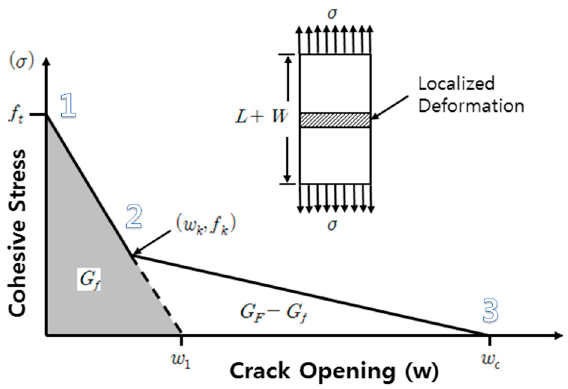
Figure 8. Bilinear approximation of the softening curve (Coronado and Lopez 2008).